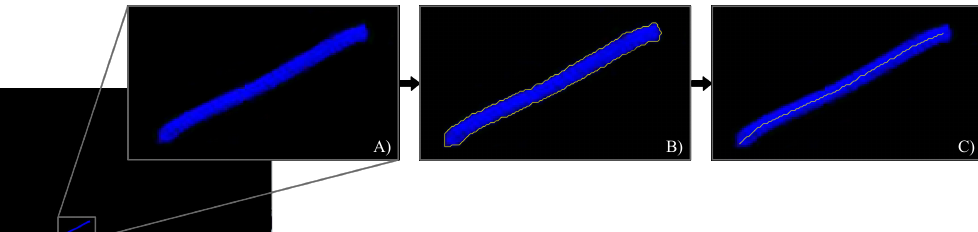
Figure 8. Feature detection on the virtual images: ( A ) Zoomed detail of the virtual osteotomy line; ( B ) Result of the threshold segmentation for boundary detection; ( C ) Final center line detection.